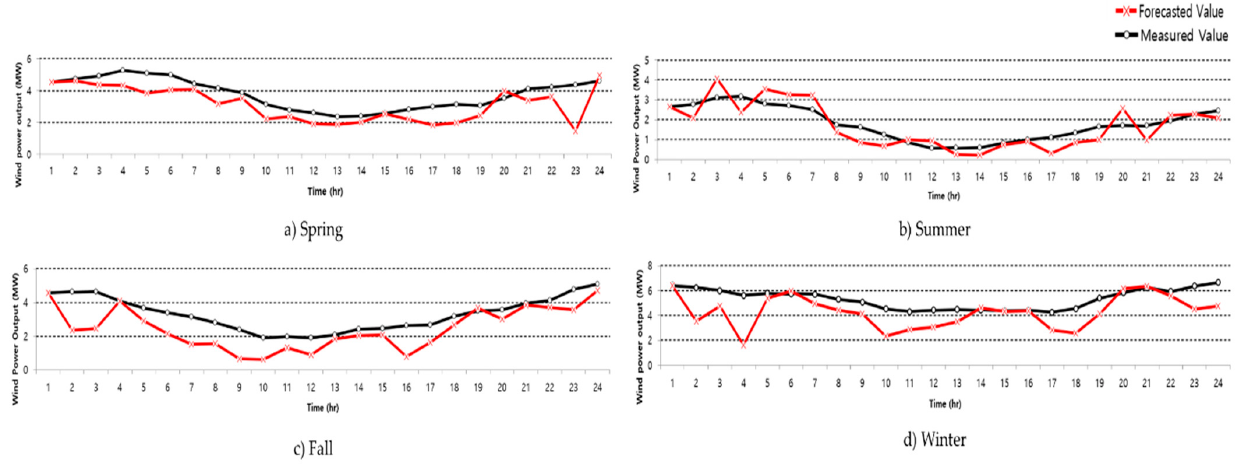
Figure 5. Wind power output comparison result: ( a ) Spring: May; ( b ) Summer: June; ( c ) Fall: November; ( d ) Winter: January.